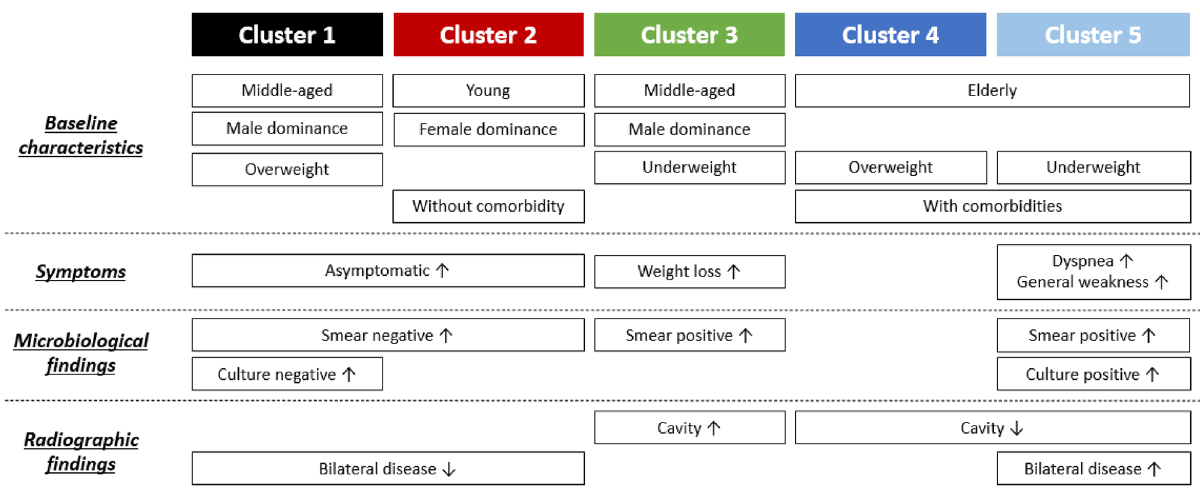
Figure 3. Summary of clinical, symptomatic, microbiological and radiologic characteristics among clusters. AFB, acid-fast